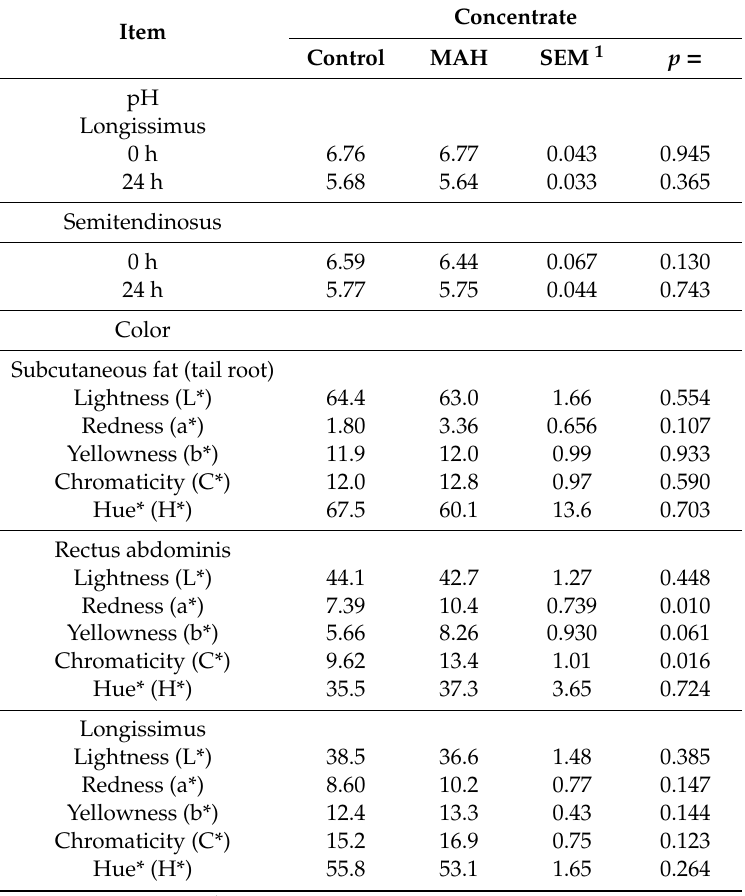
Table 2. pH and color values of di ff erent tissues of growing lambs fed barley straw and concentrate